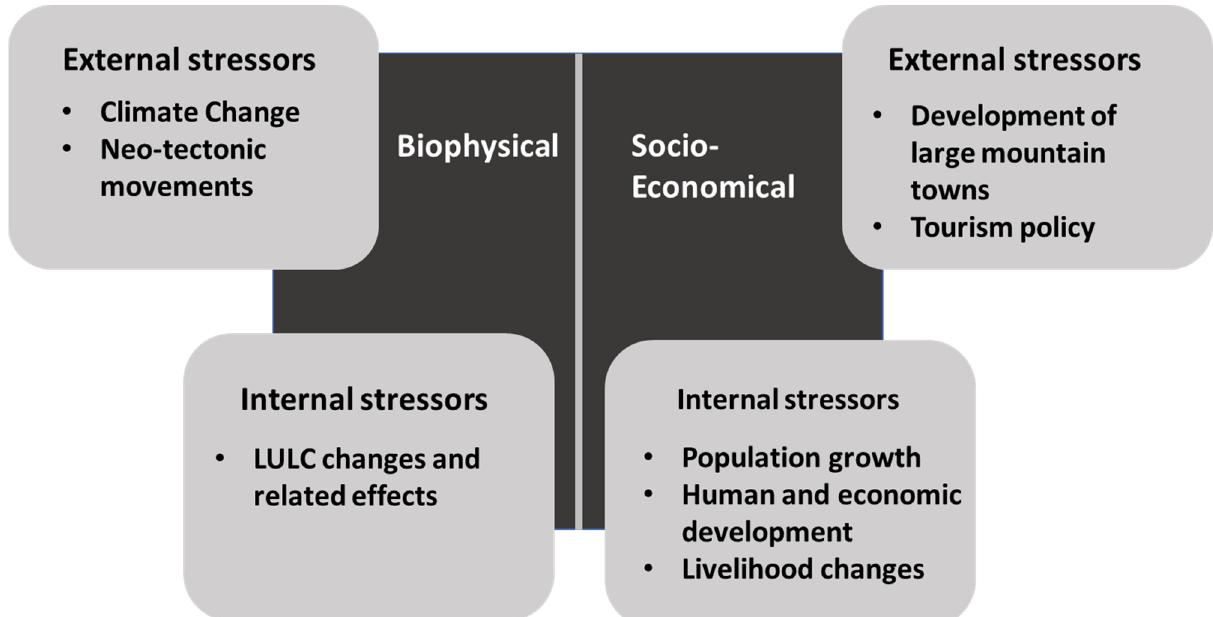
Figure 2. A conceptual representation of the challenges faced by the Himalayan springs: internal and external pressures and drivers impacting them. Table 2. Synthesis of drivers of change in the Indian